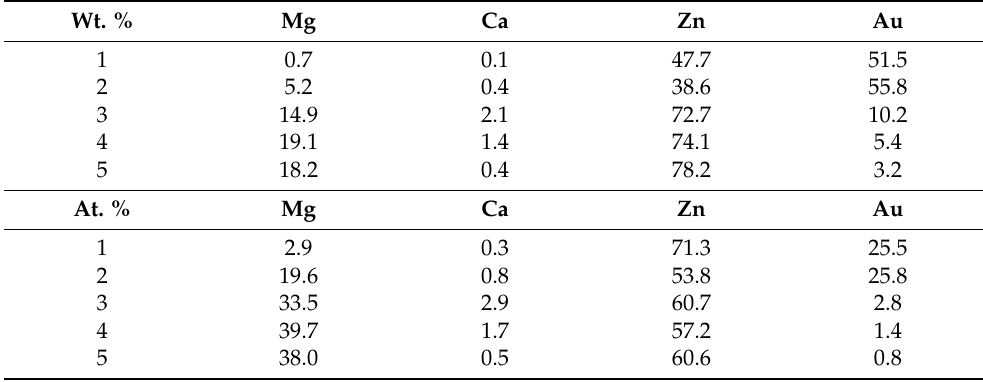
Figure 9. The SEM image featuring MgZn 2 phase regions in the sintered sample. The numbers in the image refer to the EDS analysis results which are showcased in Table 5. Table 4. EDS results from the areas marked in Figure 8.